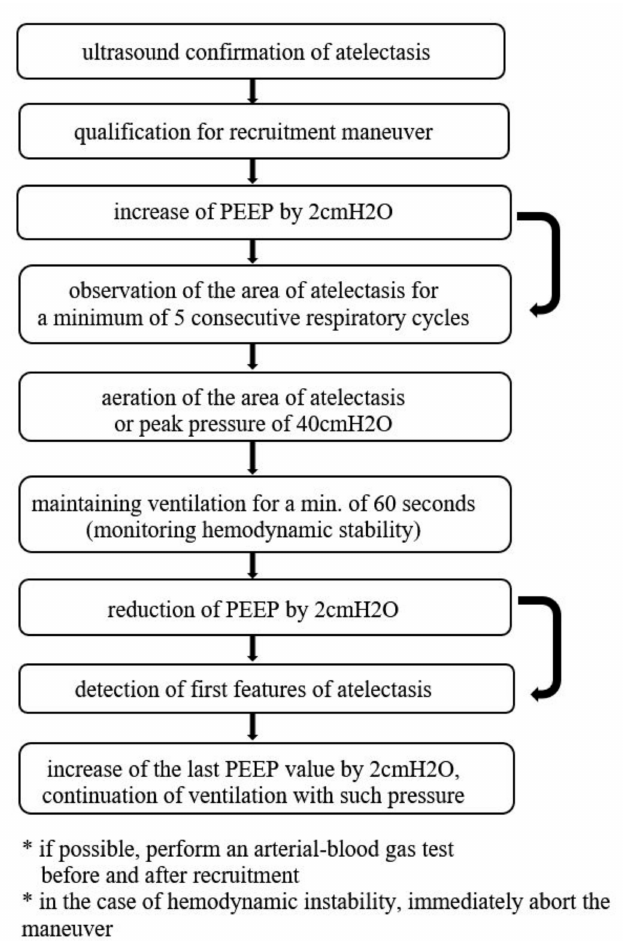
Figure 2. Recruitment maneuver algorithm employed in the study (modified Tusman’s protocol